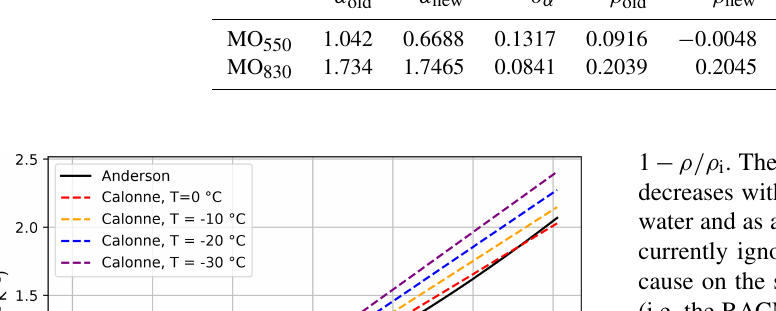
Table 1. Values of the old and new linear regression of Eq. (4) and their R 2 , as well as the standard error of the new fitting parameters. α old